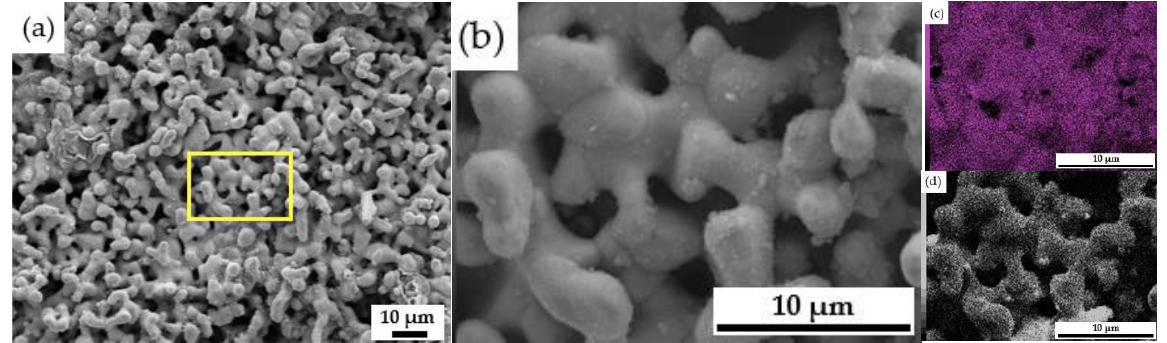
Figure 17. SEM images of electrolyzed products at 1000 times ( a ) and 5000 times ( b ) after 10 h, as well as EDS and surface scan maps at 5000 times (( c ): Ni element ( d ): O element).